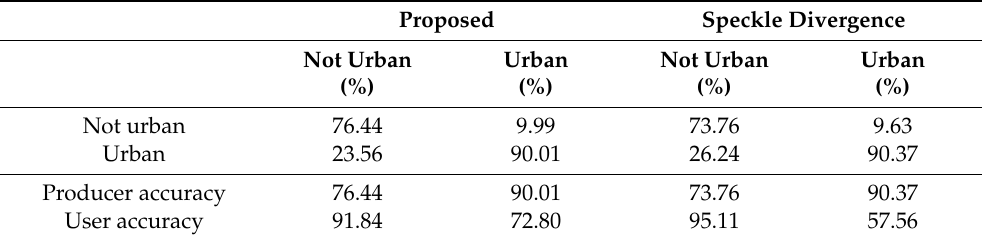
Table 3. Napoli area: confusion matrix for the urban/not urban classification using reference data derived from the Urban Atlas. Proposed methodology—overall accuracy: 81.93%, kappa coefficient: 0.63. Urban density windows ~150 m and ~450 m. Speckle divergence—overall accuracy: 78.45%, kappa coefficient 0.59. Threshold set to